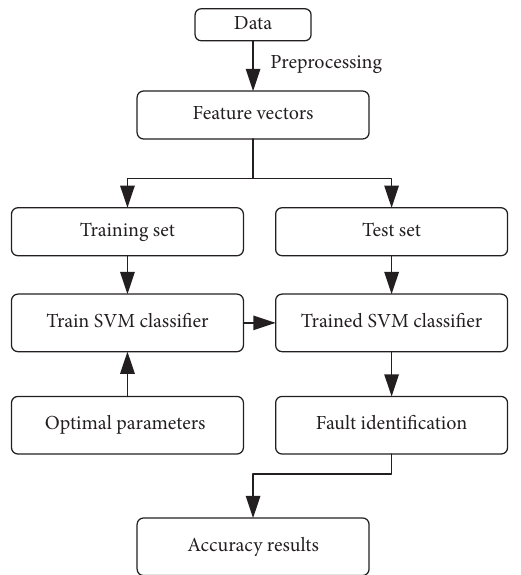
Figure 1: Flowchart of fault identification based on